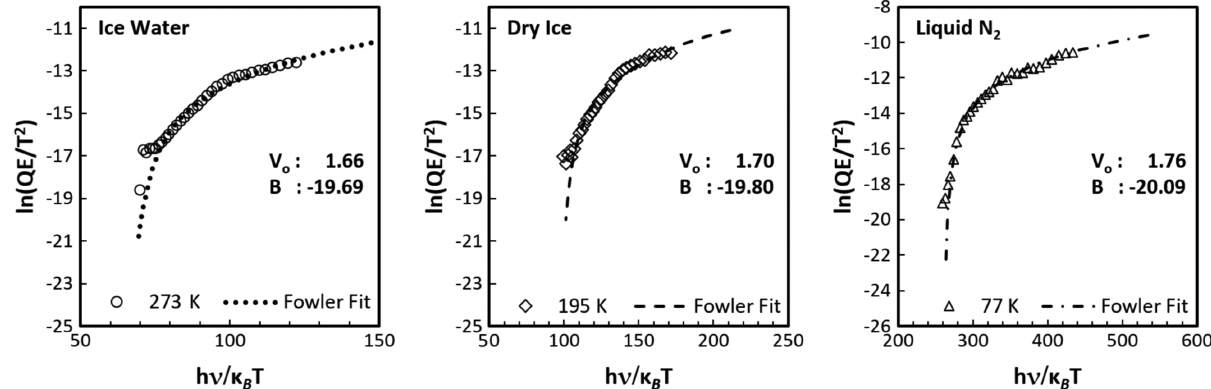
K Sb photocathode grown on the Nb substrate measured at the indicated temperatures using x y